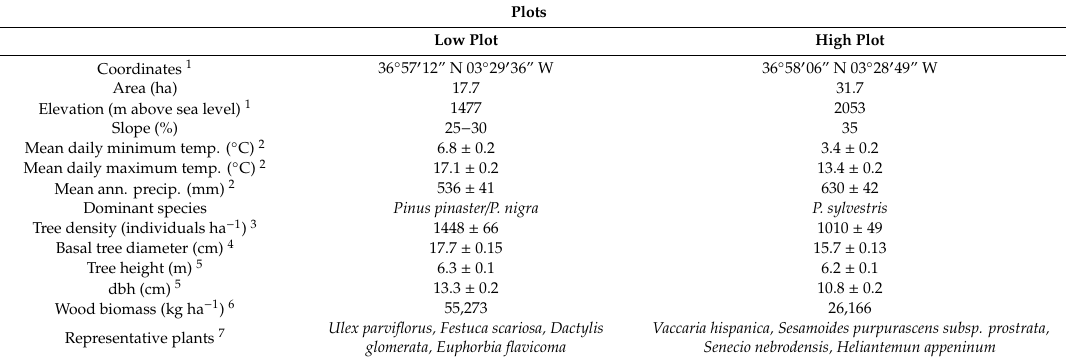
Table 1. Location and characteristics of the study